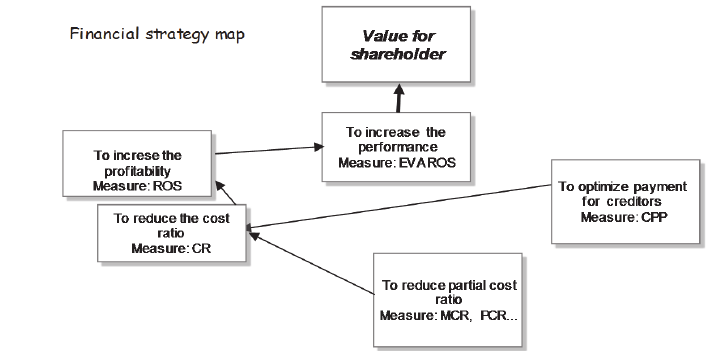
Fig. 2. Financial strategy management